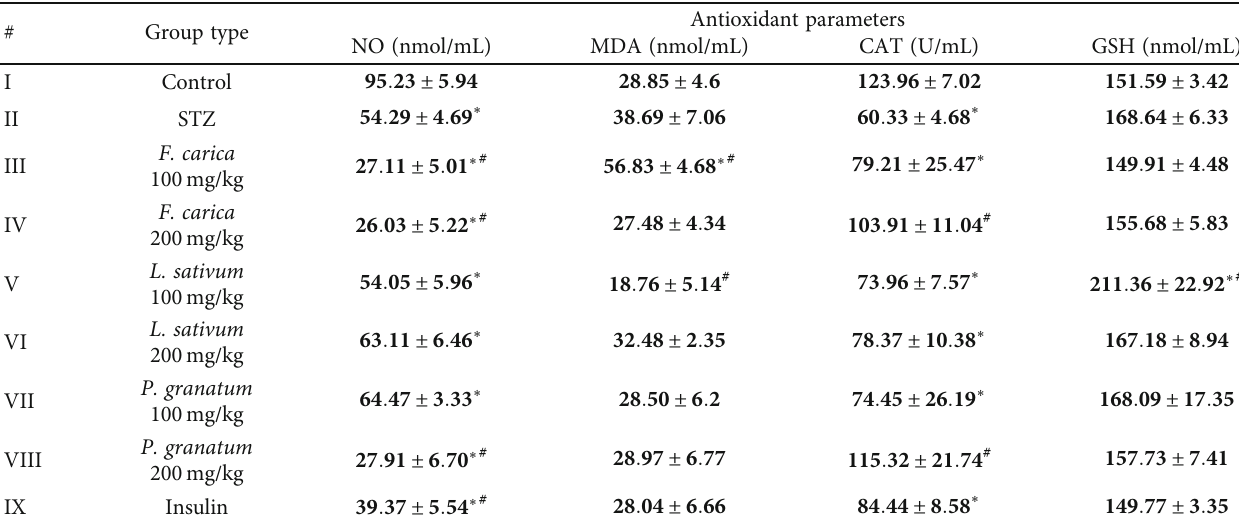
Values are given as mean ± SD signi fi cantly di ff erent at p < 0 : 05 for groups of nine animals each. ∗ Statistically signi fi cant compared to the corresponding value in group I. # Statistically signi fi cant compared to the corresponding value in group